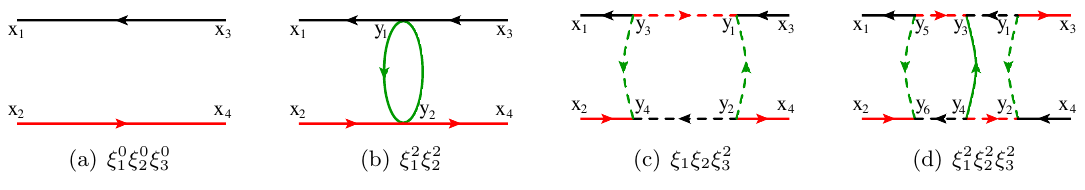
Figure 13 . First contributions to the four-point functions G